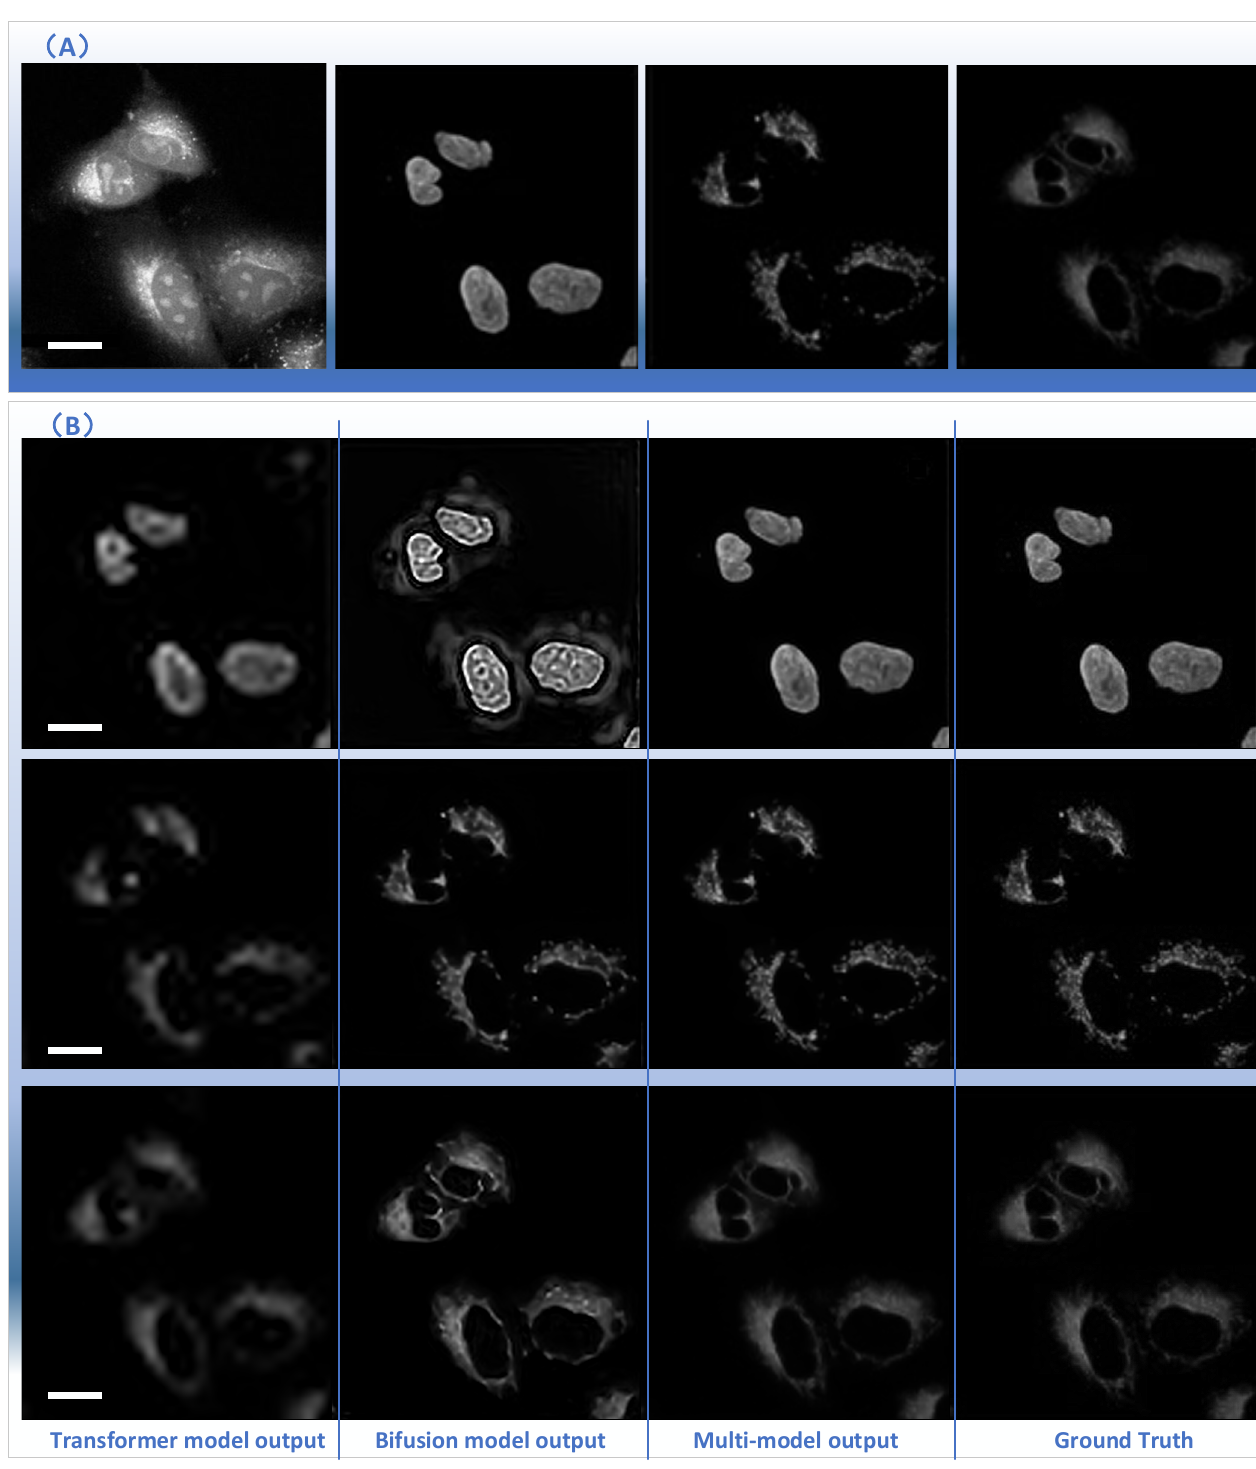
Figure 2. Subcellular localization prediction results of differentiation model from label-free cell imaging experiments. The results for different organelle locations, including nuclei (second column), mitochondria (third column), and endoplasmic reticulum (right) from the single raw SRS imaging cell (left), are shown in ( A ). The prediction results for organelle locations, including nuclei (top row), mitochondria (third column), and endoplasmic reticulum (bottom row), from the raw SRS imaging cells (left) are shown in ( B ). Scale bar, 25 μm.